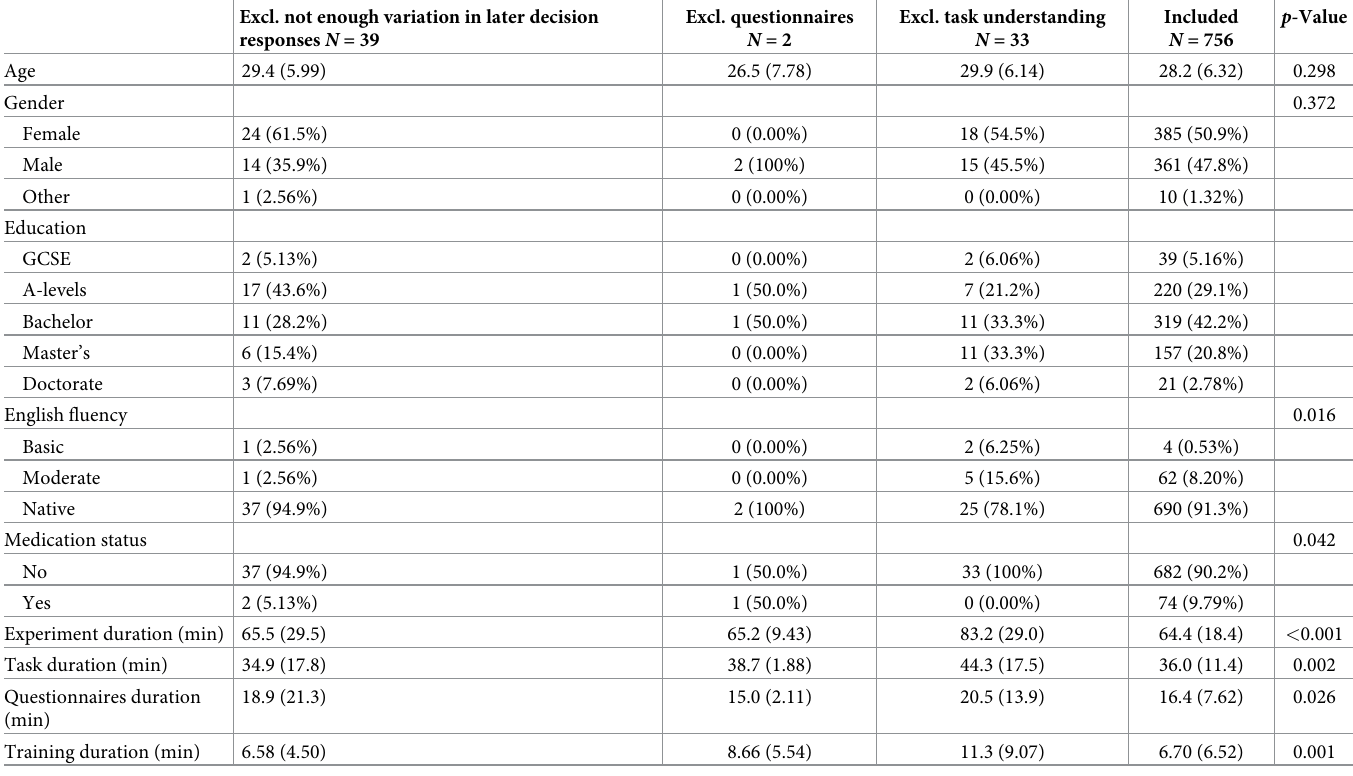
Table 1. Demographics and experiment duration for participants of the confirmation sample that we included or excluded from all analyses based on questionnaire and task performance criteria (see Methods).